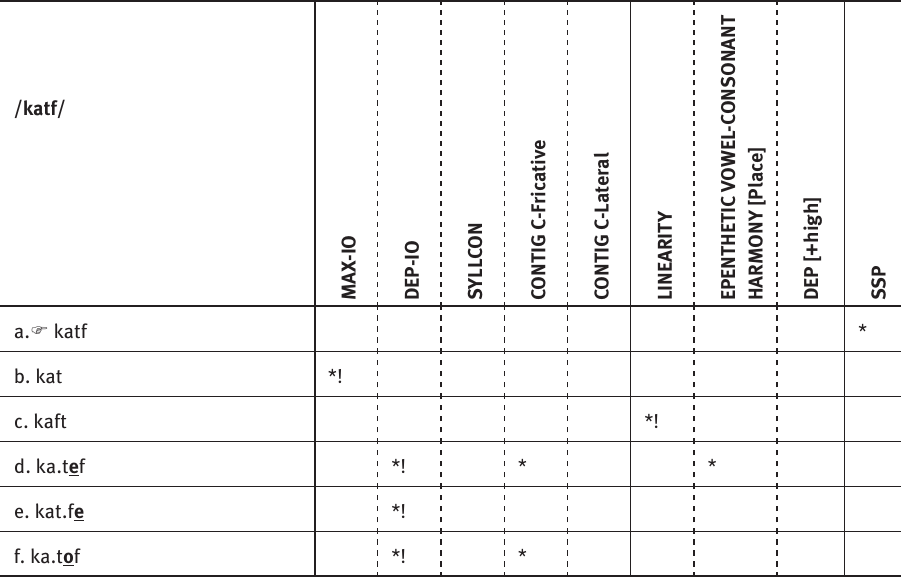
Table 17 : MAX-IO, DEP-IO, SYLLCON, CONTIG C-Fricative, CONTIG C-Lateral >>LINEARITY, EPENTHETIC VOWEL-CONSONANT HARMONY [Place], DEP [+high]>>SSP